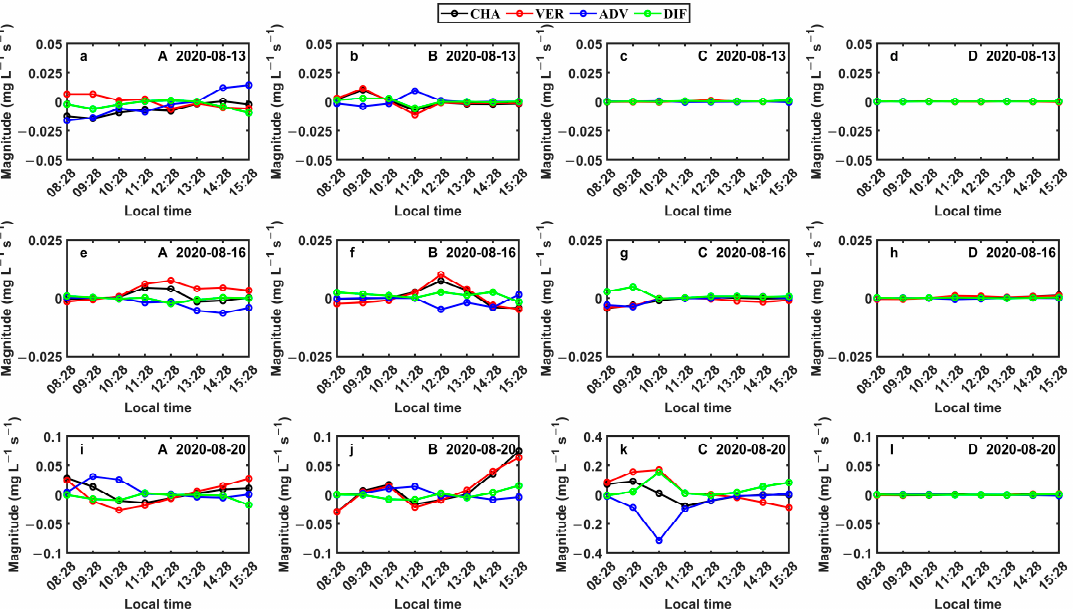
Figure 15. ( a – d ) are the variations of the four terms (local change (CHA), vertical direction (VER), horizontal advection (ADV), and horizontal diffusion (DIF)) at the four typical points A, B, C, and D during the neap tide, respectively. ( e – h ) and ( i – l ) are the same as ( a – d ) but for the middle and spring tides, respectively.